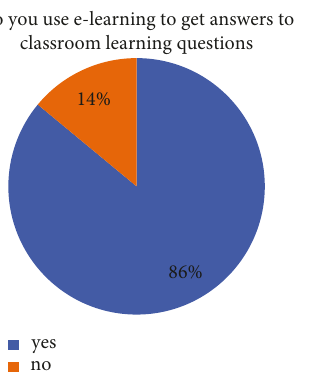
Figure 13: Survey of students’ access to answers for online